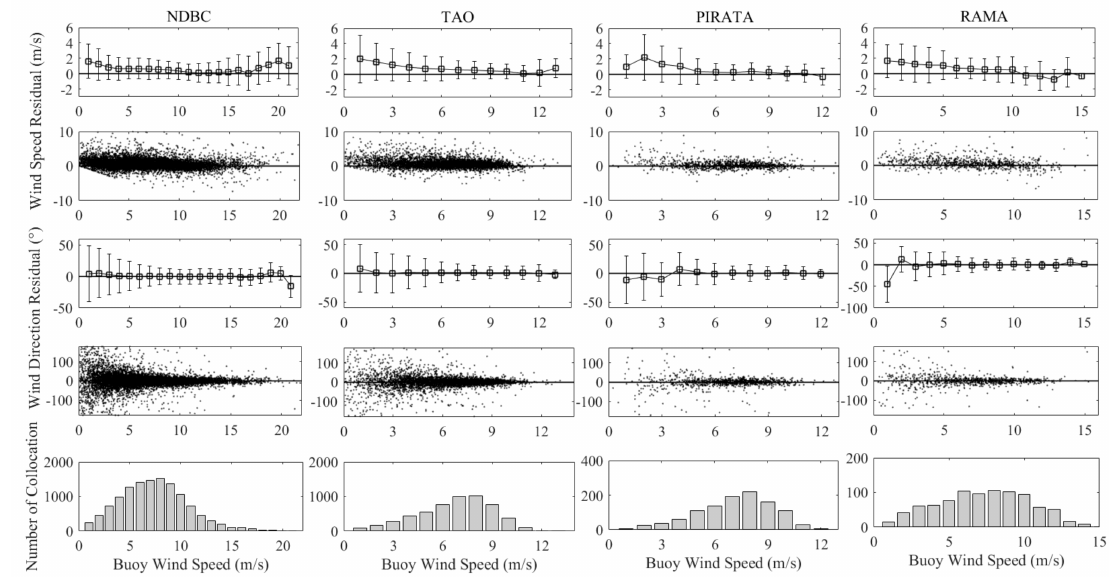
Figure 5. Dependence of statistical parameters and wind speed and direction residuals (RapidScat-buoy) on the buoy wind speed.